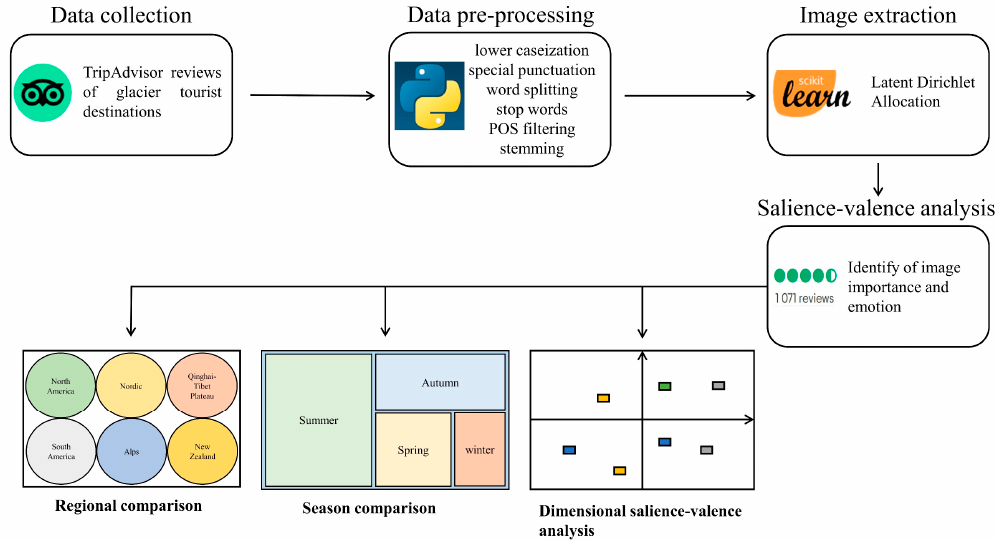
Figure 2. Research process.